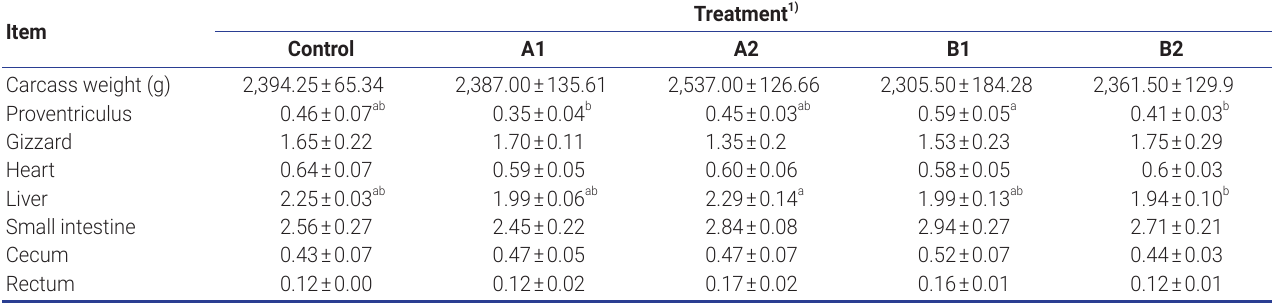
Table 3. Effects of dietary metallo-protease and Bacillus velezensis CE 100 addition on carcass and organ weight in broiler chickens (g/100 g BW)